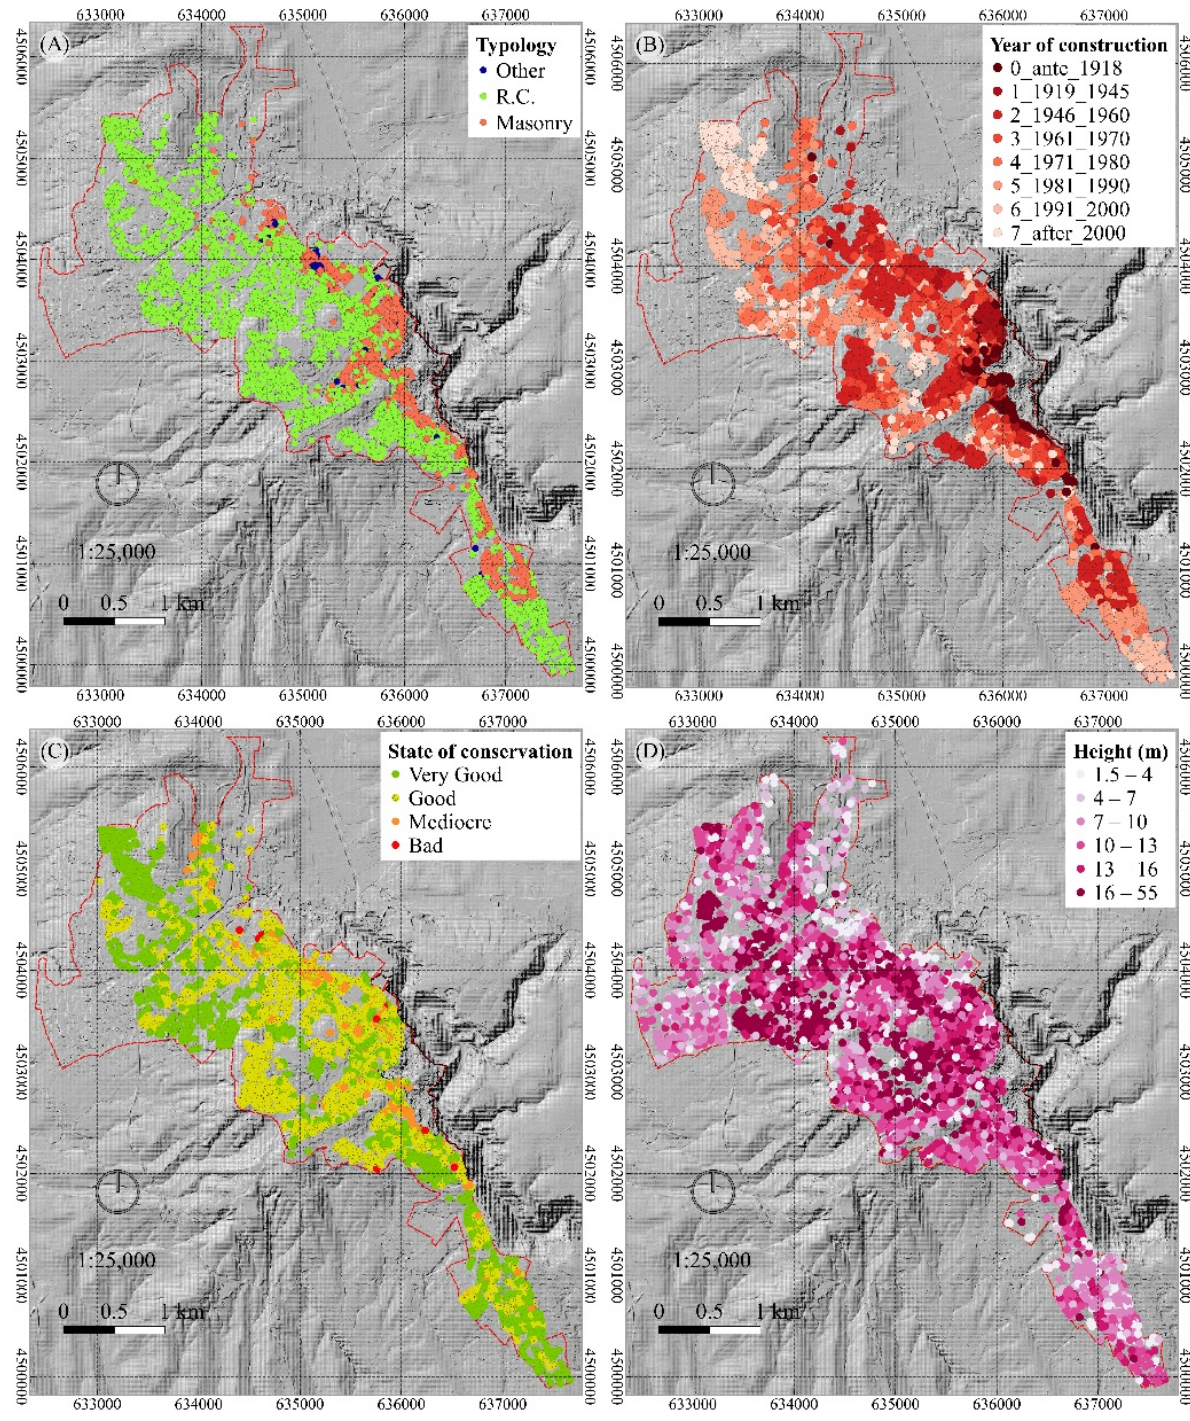
Figure 1. Spatial distribution of building characteristics: ( A ) building typology; ( B ) year of construction; ( C ) state of conservation; ( D ) height max (m). The black dashed line encloses the ‘SASSI’ area (not included in this study). The red dashed line delimits the urban area on which the study is focused.